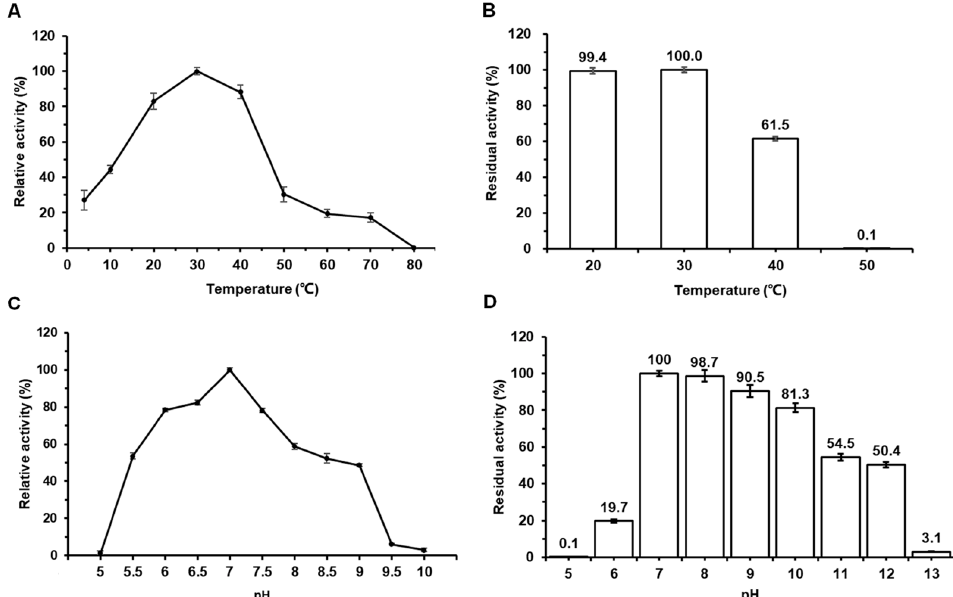
Figure 2. Effects of temperature and pH on the activity and stability of Amy117. ( A ) Effects of temperature on Amy117 activity. To determine the optimal temperature of Amy117, the reaction was conducted from 4 to 80 °C in sodium phosphate buffer (pH 7.0); ( B ) Effects of temperature on Amy117 stability. The thermal stability of Amy117 was determined at 20–60 °C in sodium phosphate buffer (pH 7.0) for 30 min. After incubation, the residual activity of Amy117 was measured at pH 7.0 and 30 °C; ( C ) Effects of pH on Amy117 activity. The reactions were conducted at 30 °C in different pH buffers; ( D ) Effects of pH on Amy117 stability. The stability of Amy117 was determined at different pH from 5.0 to 13.0 at 4 °C for 16 h. After incubation, the residual activity was measured at pH 7.0 and 30 °C. Each value of the assay was the arithmetic mean of triplicate measurements.